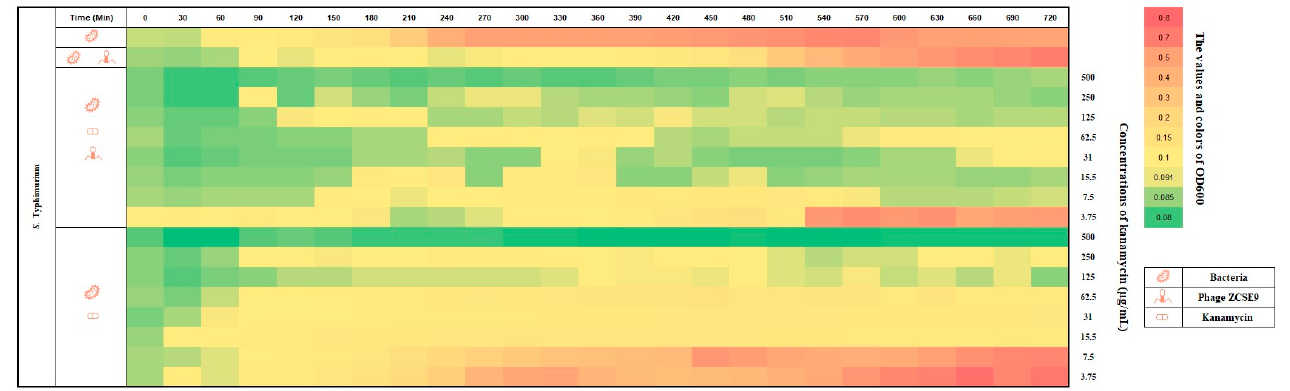
Figure 10. Heat plot for the synergy of phage ZCSE9 and kanamycin against S. Typhimurium (NCTC 13348) . The bacterial growth at OD 600 was represented with colors and numbers in the right vertical bar; red is the highest growth, and green is the lowest.